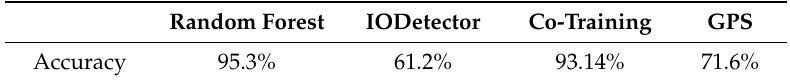
Figure 12. Screen shot of the updated application. The updated application records the light intensity, cellular signal strength, magnetic variance, sound intensity, and visible GPS satellites in the memory. Table 6. Accuracy comparison among the proposed algorithm, IODetector, Co-Training and GPS based detection.